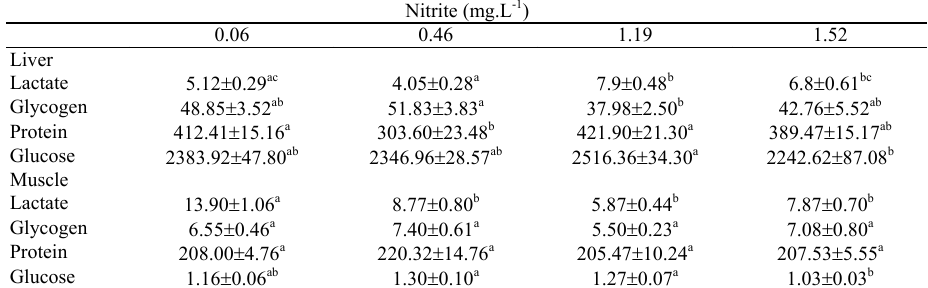
Table 2. Metabolic parameters of liver and muscle of silver catfish juveniles exposed to different waterborne nitrite levels for 40 days. Lactate, glycogen and glucose in μ mol.g -1 . Protein in mg.g -1 . N = 10. Values are expressed as mean ± SEM. Different letters in the rows indicate significant difference among treatments by one-way ANOVA and Tukey test